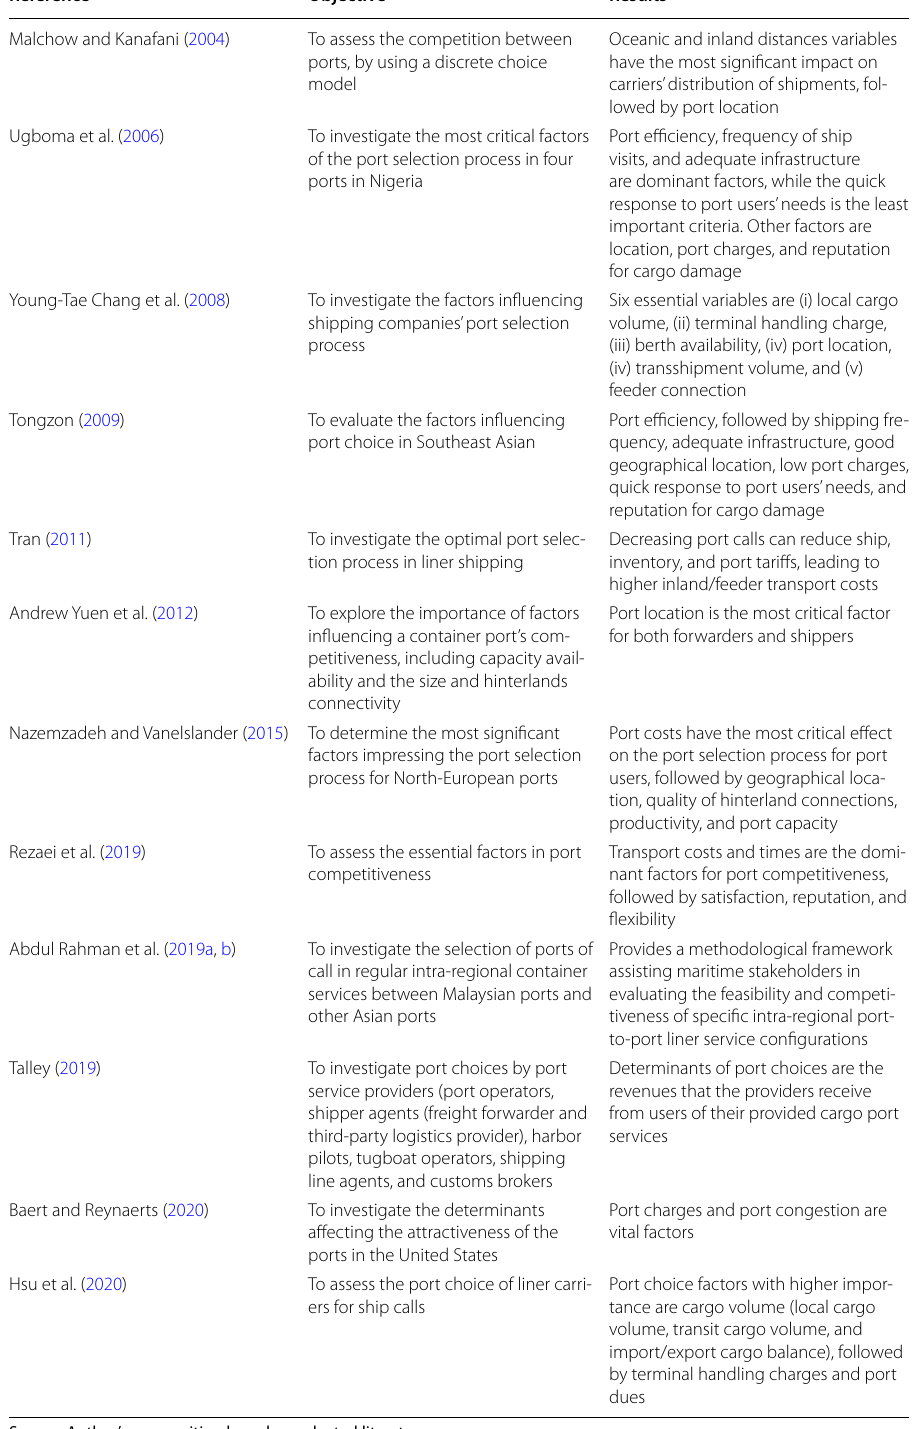
Table 2 A literature review on port choice